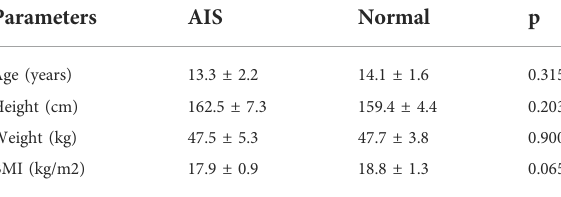
TABLE 1 Demographic characteristics of study participants ( n = 34).